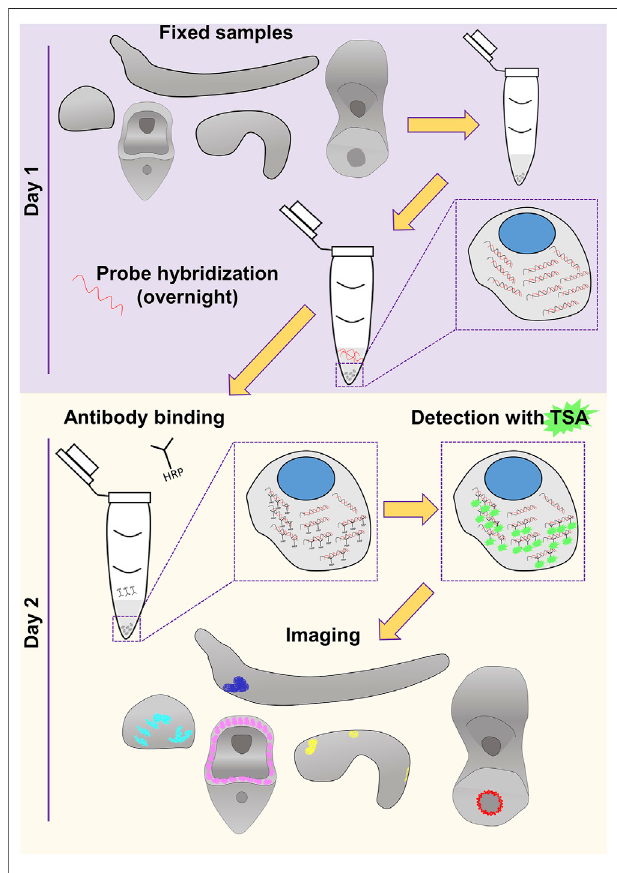
FIGURE 4 | Overview of the FISH procedure described in this study. Schematics of the embryos and larvae used to test the protocol are represented in gray. Color code of the staining corresponds to what used in Figures 1 – 3